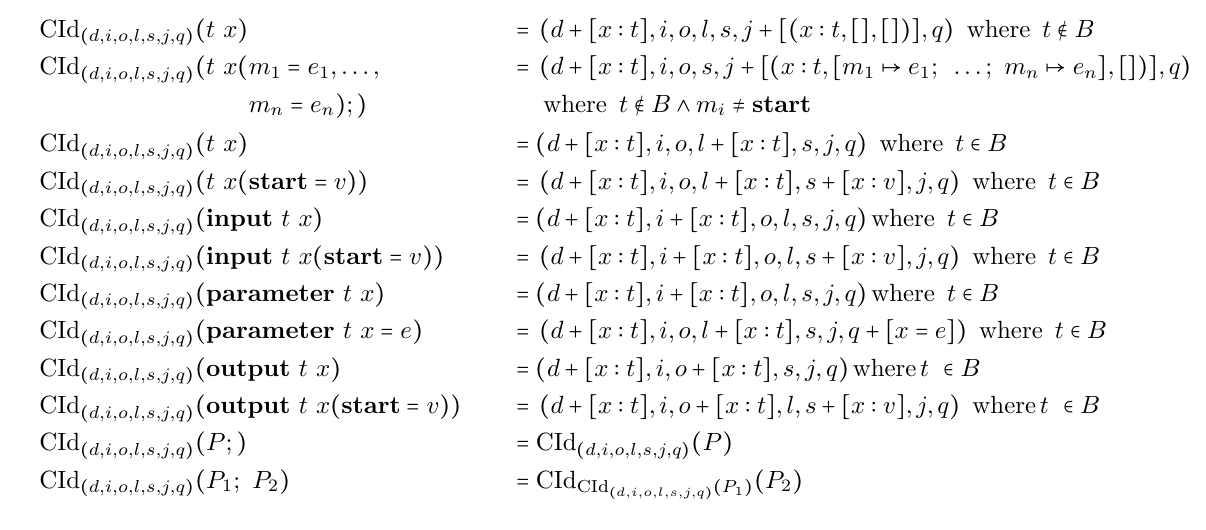
Figure 4: Function CId—Create auxiliary structure for instance declarations.